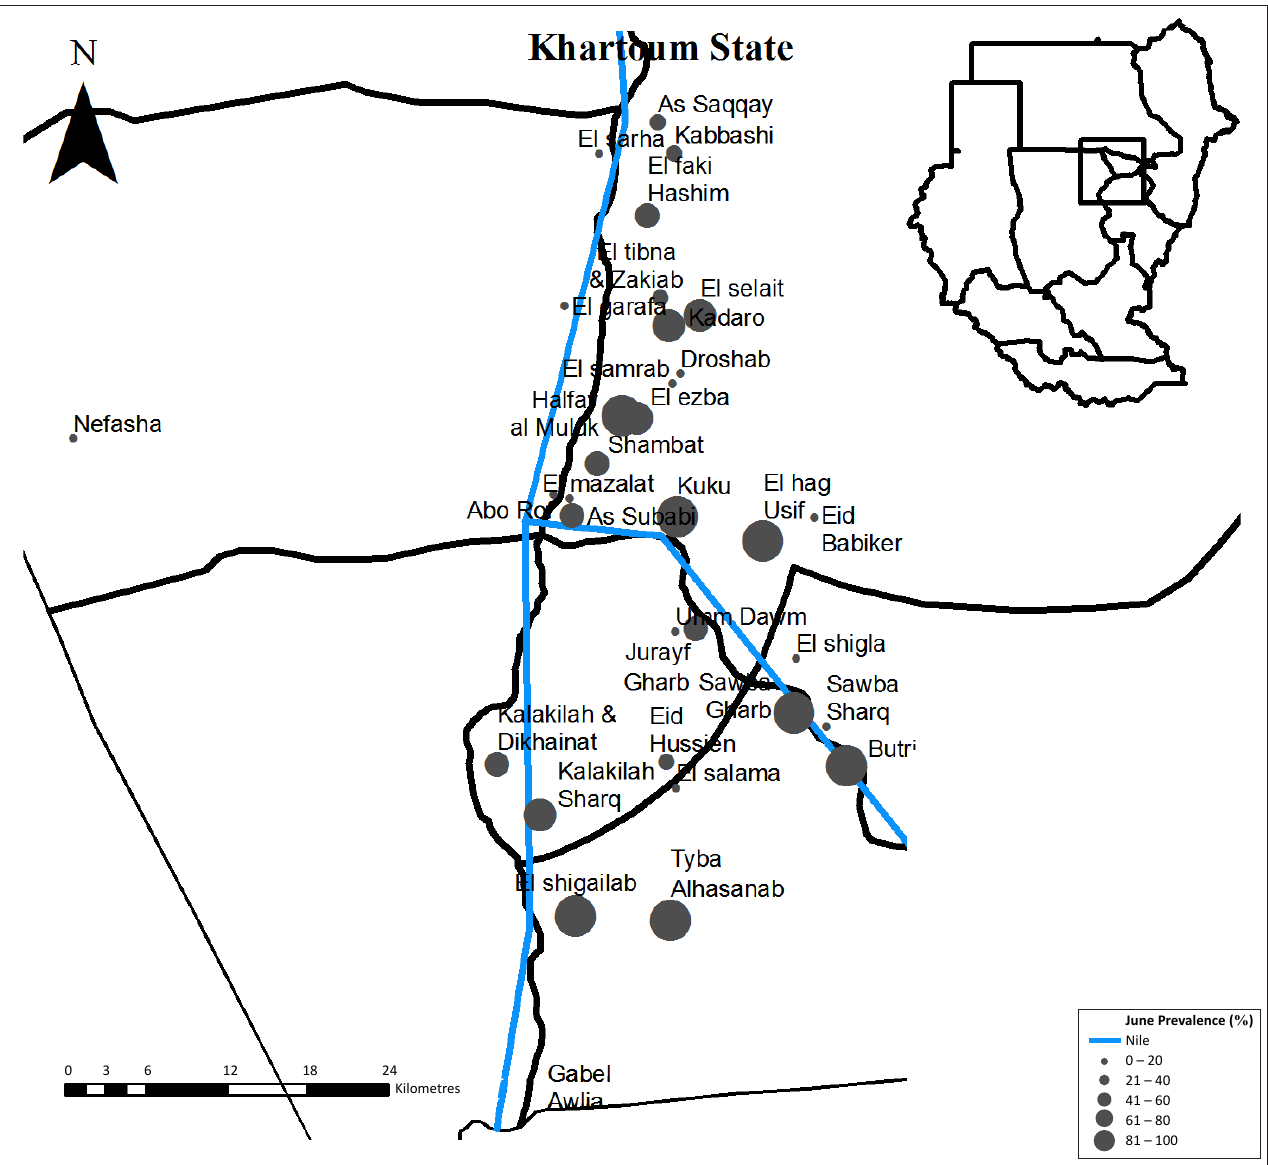
Source : Figure created from census data by using ArcGIS FIGURE 3: Spatial distribution of antimicrobial residues in Khartoum State farms surveyed in June